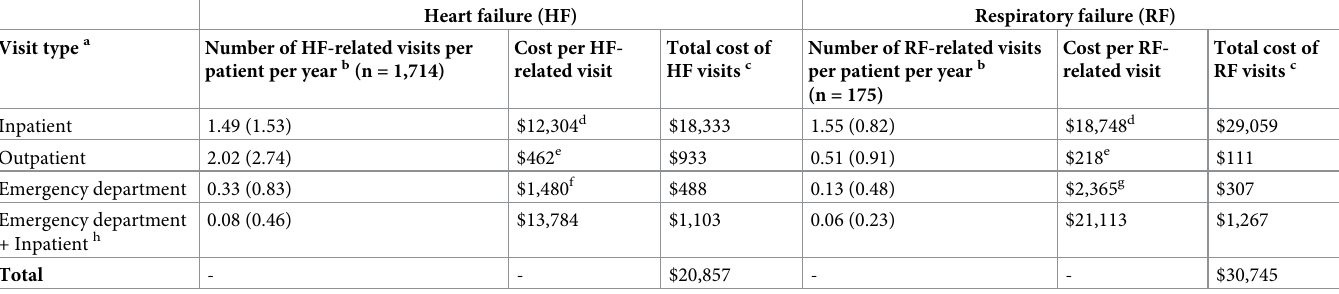
Table 4. Healthcare utilization by patients requiring treatment for respiratory failure and heart failure complications during the one-year follow-up period. Heart failure (HF) Respiratory failure